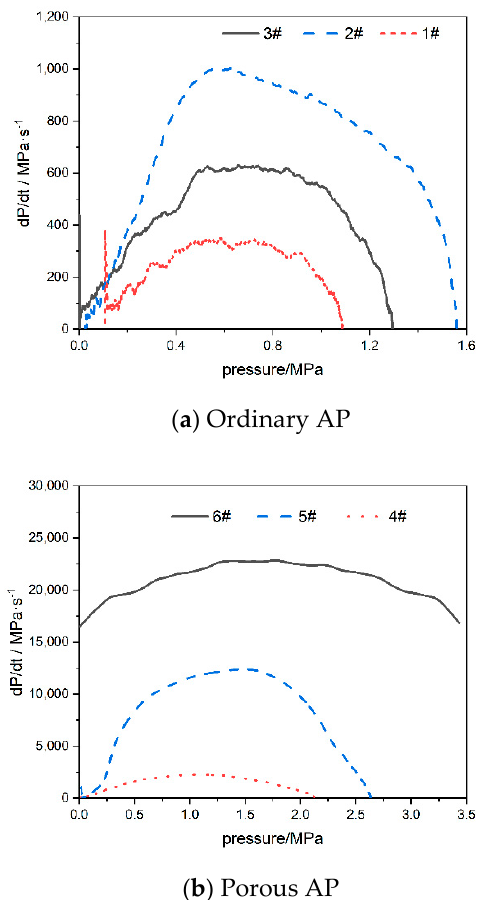
Figure 12. dp/dt–p curve for ordinary and porous AP. Table 4. Combustion characteristics of the AP-Al closed bomb for different AP:Al proportions.